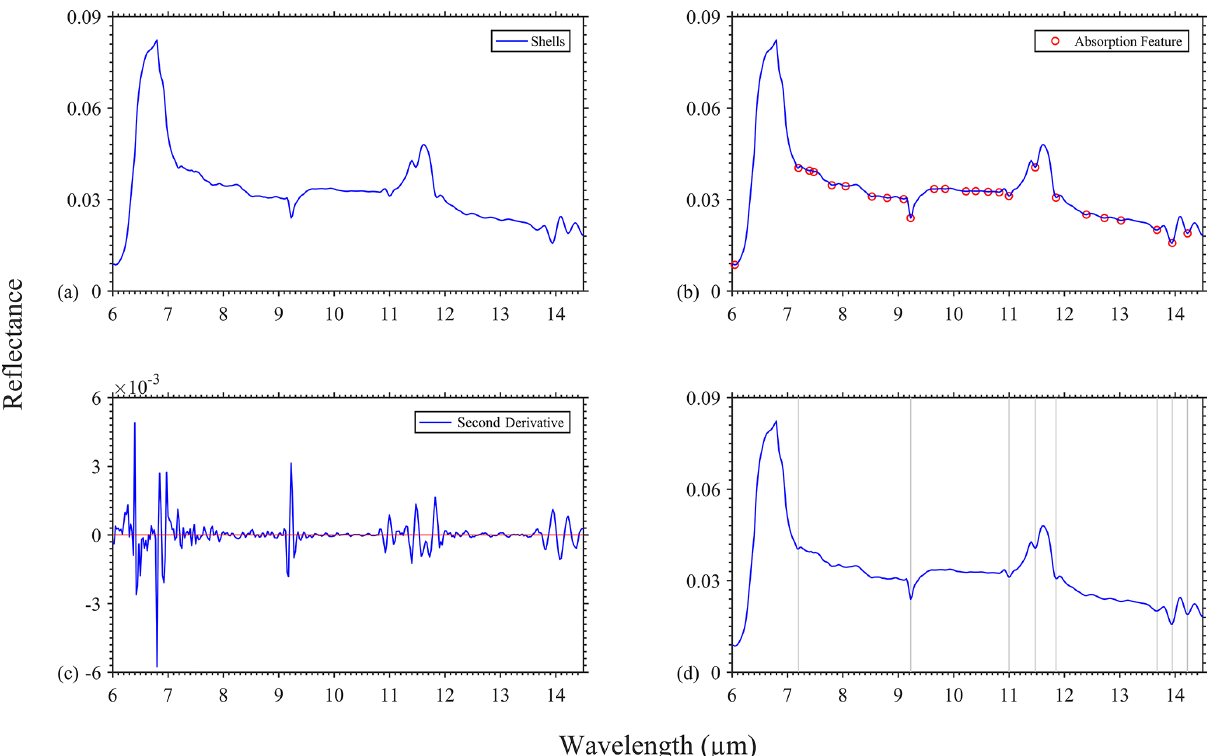
Figure 3. (a) Spectral reflectance of shells gathered along the shorelines of Punta Mallil-Cuem, Detif and Punta Apabón on the Chiloé Archipelago, Chile; (b) absorption features automatically picked; (c) second-derivative spectra; and (d) an end-member signal with the proposed diagnostic absorption features highlighted by the vertical